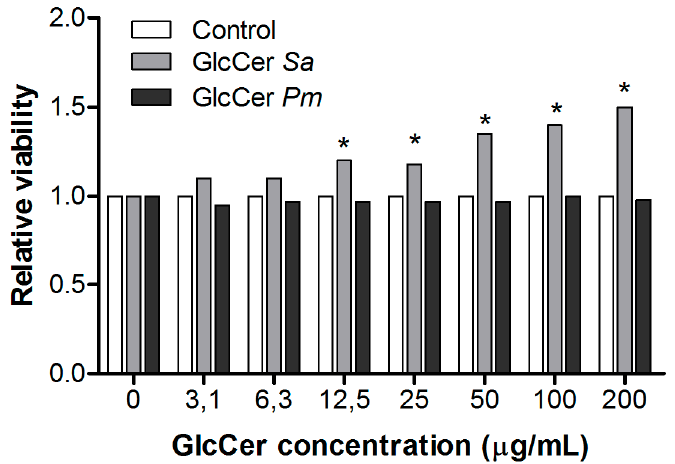
Figure 5. Peritoneal macrophages activation by purified glucosylceramides (GlcCers) from S. aurantiacum (Sa) and P. minutispora (Pm). Cell viability was measured by neutral-red dye uptake assay, and the results are presented as relative viability compared to the control. * p < 0.05. Macrophage fungicidal activity was also evaluated by nitric oxide (NO) production after incubation with S. aurantiacum and P. minutispora conidia and purified GlcCer (50 and 100 µ g / mL). Conidia of both fungi induced nitric oxide production. Regarding purified GlcCer, only S. aurantiacum GlcCer significantly increased nitric oxide production at 50 and 100 µ g / mL, while P. minutispora GlcCer did not significantly induce NO production, indicating that structural di ff erences could influence NO production (Figure